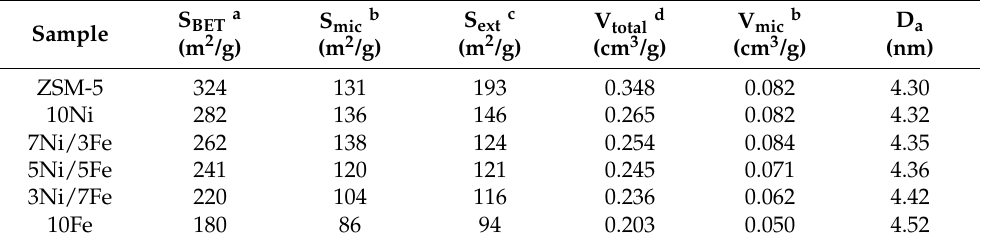
Table 1. Texture properties of all